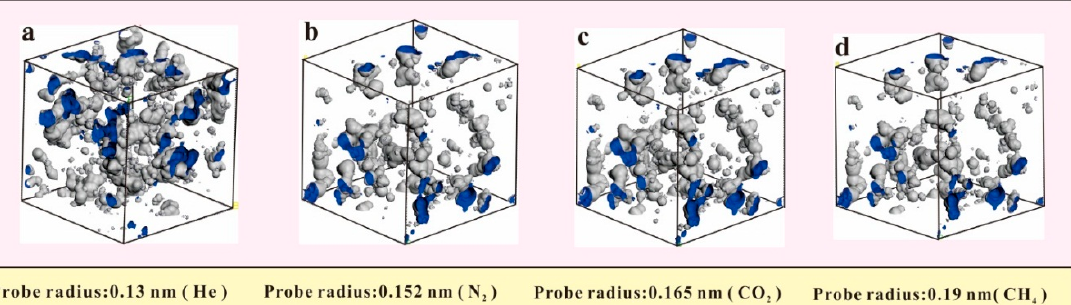
Figure 6. Different sizes of probe molecular pores. ( a ) the pores were measured by He. ( b ) the pores were measured by N 2 . ( c ) the pores were measured by CO 2 . ( d ) the pores were measured by CH 4 .